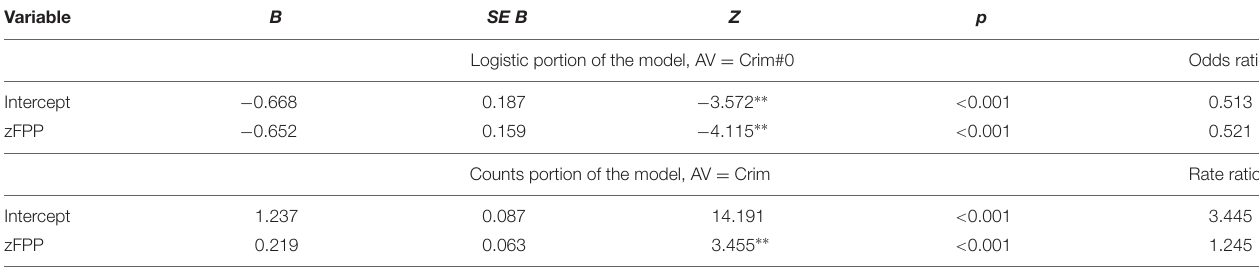
TABLE 6 | Summary of zero inflated negative binomial regression for FPP predicting crime ( n = 278). Variable B SE B